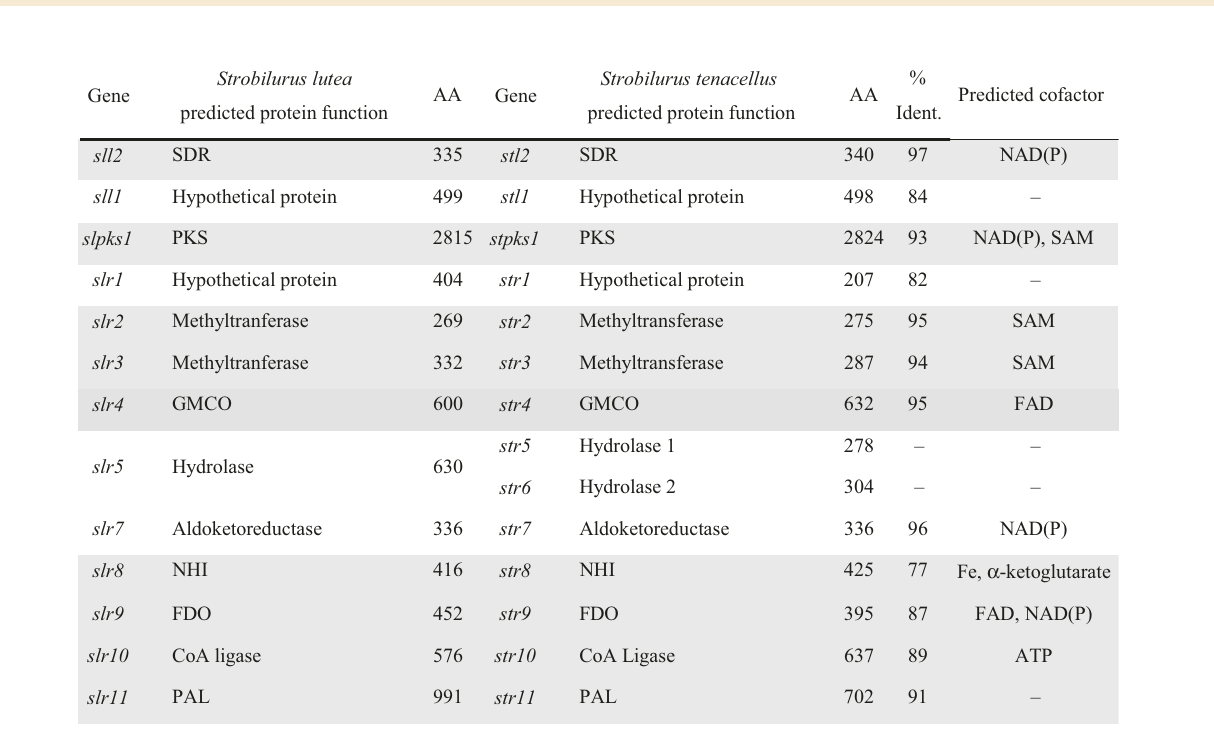
Table 1 Detected genes located adjacent to pks1